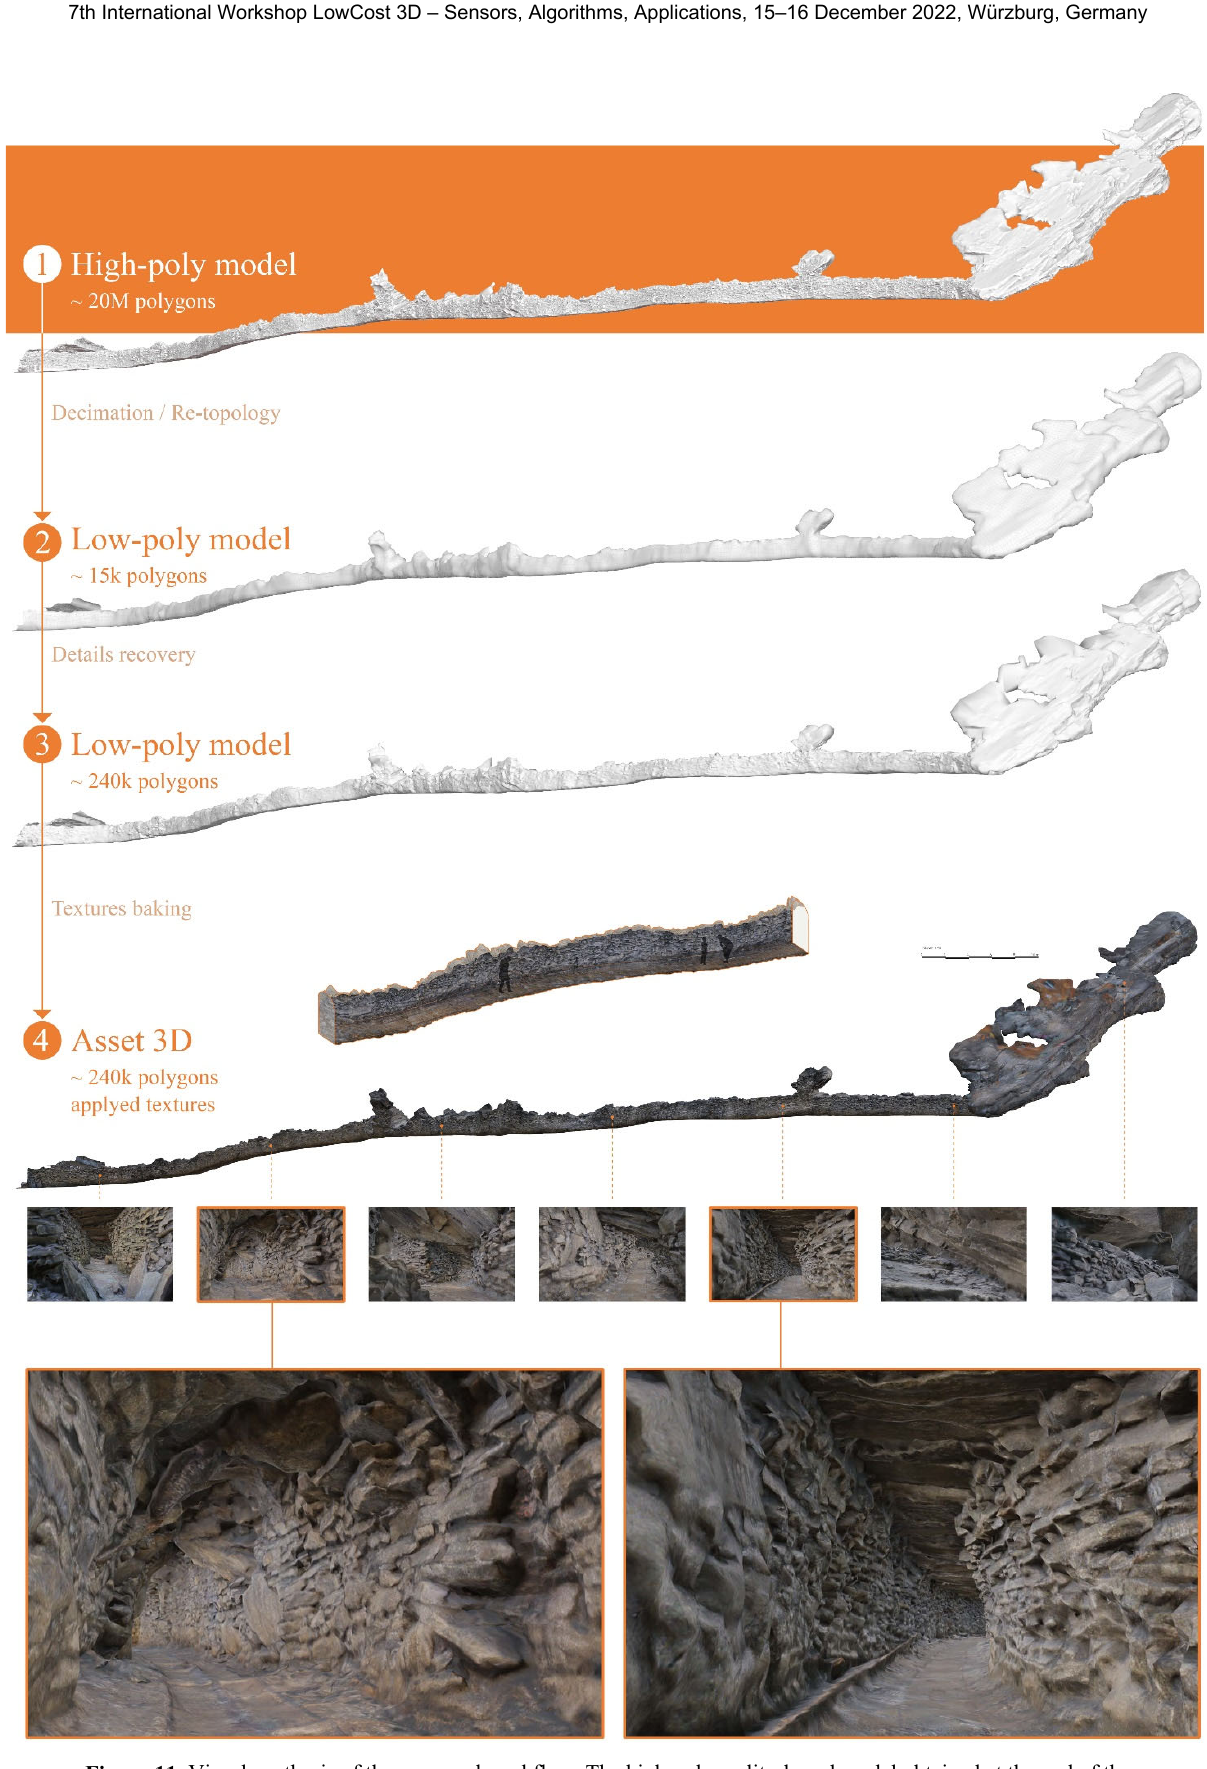
Figure 11. Visual synthesis of the proposed workflow. The high-poly reality-based model obtained at the end of the photogrammetric process is turned into a 3D asset usable for VR and AR